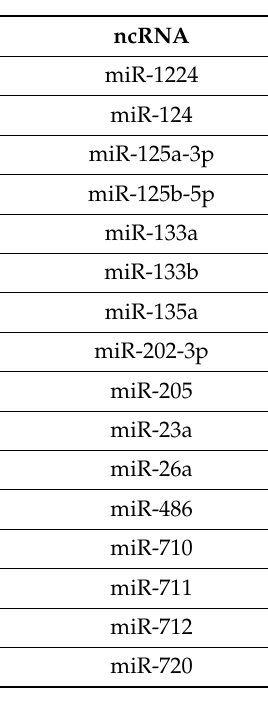
Table 2. Potential ncRNA biomarkers from blood, plasma, or